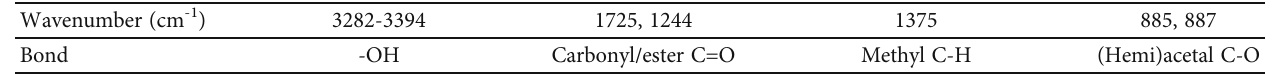
Table 1: Some characteristic peaks in FTIR spectra of the KG